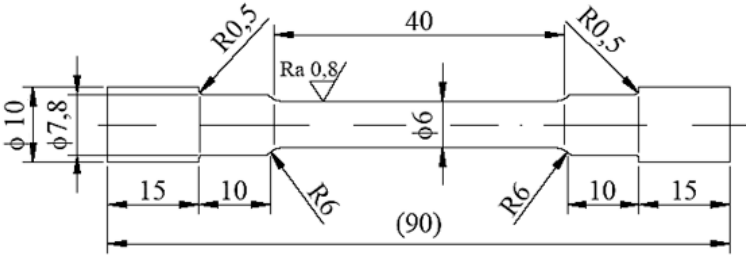
Figure 6. Geometry of the sample for static tension test.